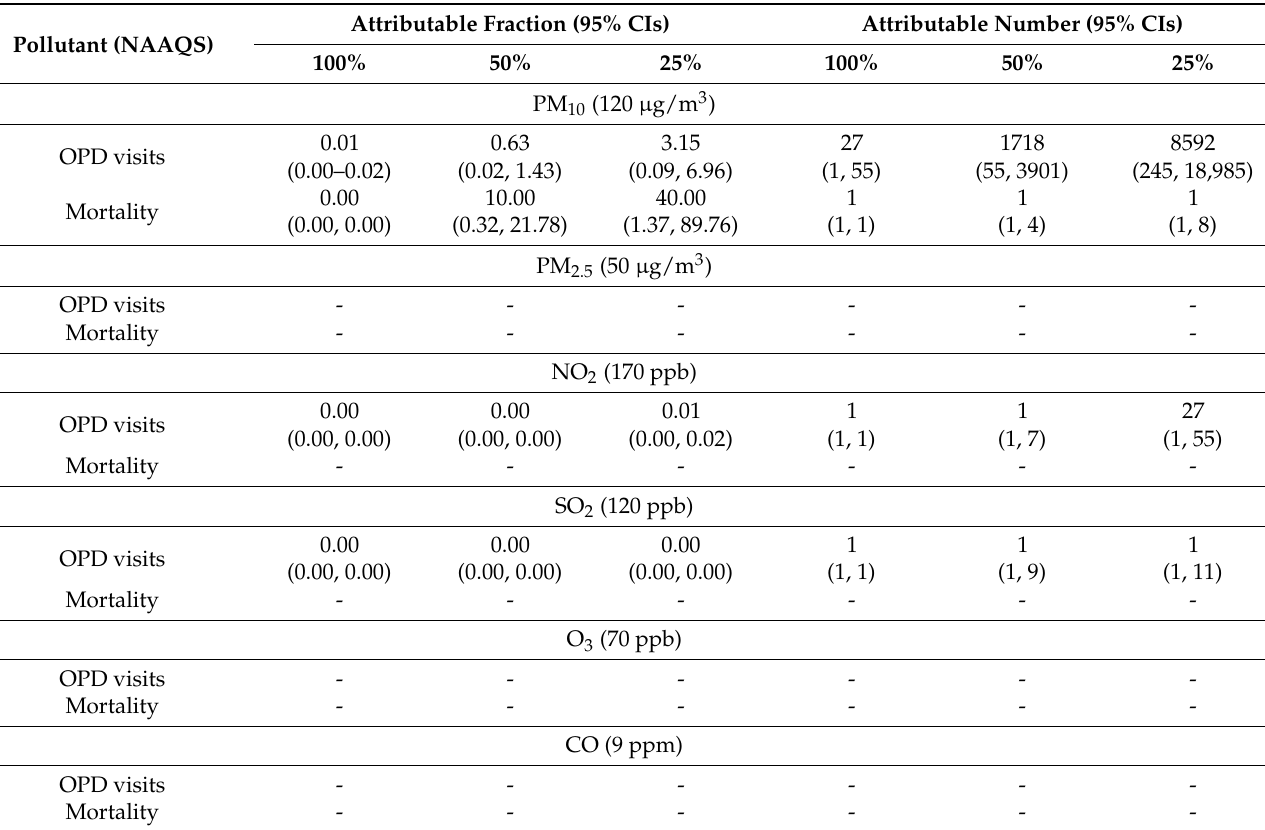
Table 12. Attributable fractions and attributable numbers of outpatient department (OPD) visits